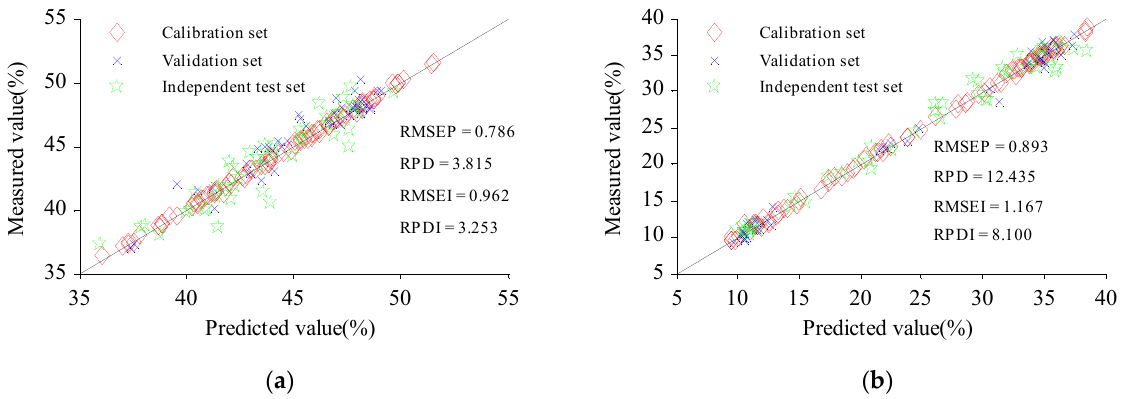
Figure 6. Prediction scatter plot for cellulose (a) and hemicellulose (b). RMSEI and RPDI represent the RMSE and RPD of the independent test set, respectively.